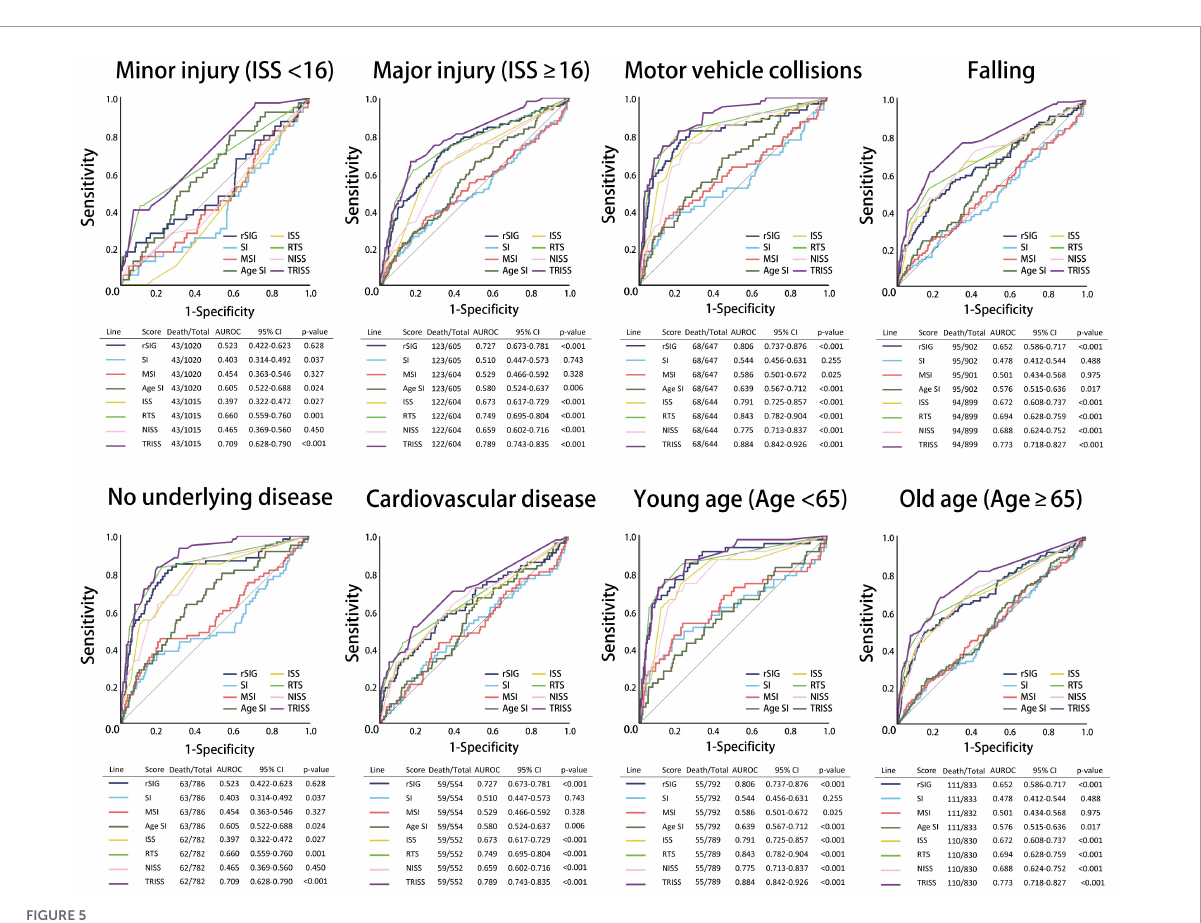
was not significantly predicted for mortality in mild injury population with AUC: 0.465 under 95% CI of 0.369–0.560. In SI, MSI, ASI, and rSIG scoring systems, rSIG had better prediction accuracy of mortality in TBI in the major trauma, motor vehicle collisions, falls, and no underlying disease population. rSIG also had a better prediction effect, as